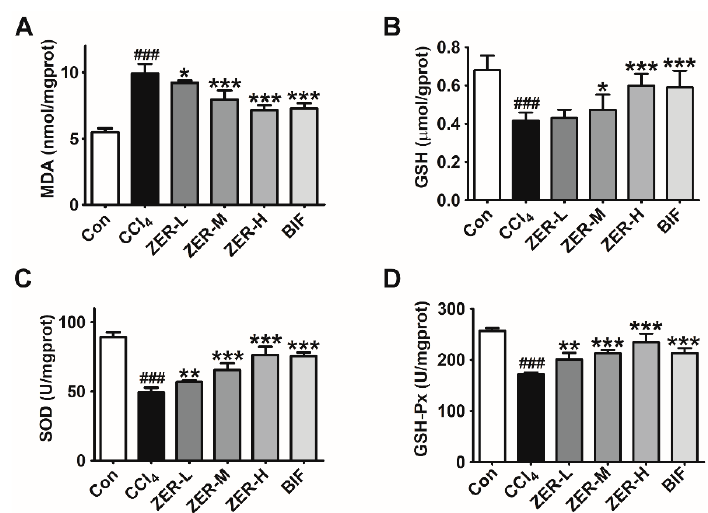
Figure 3. Effects of ZER on oxidative stress parameters ( A ) MDA, ( B ) GSH, ( C ) SOD, and ( D )GSH-Px in liver tissue of CCl 4 -induced ALI mice. Values represent the mean ± SD (n = 10). ### P < 0.001 compared with the control group; * P < 0.05, ** P < 0.01, and *** P < 0.001 compared with the CCl 4 -treated group.